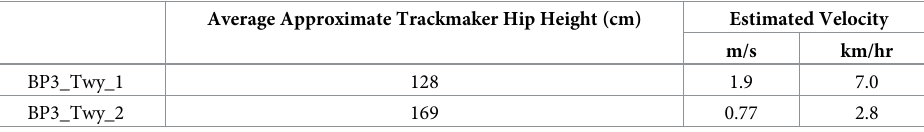
Table 6. BP3 large bipedal trackmaker size and velocity